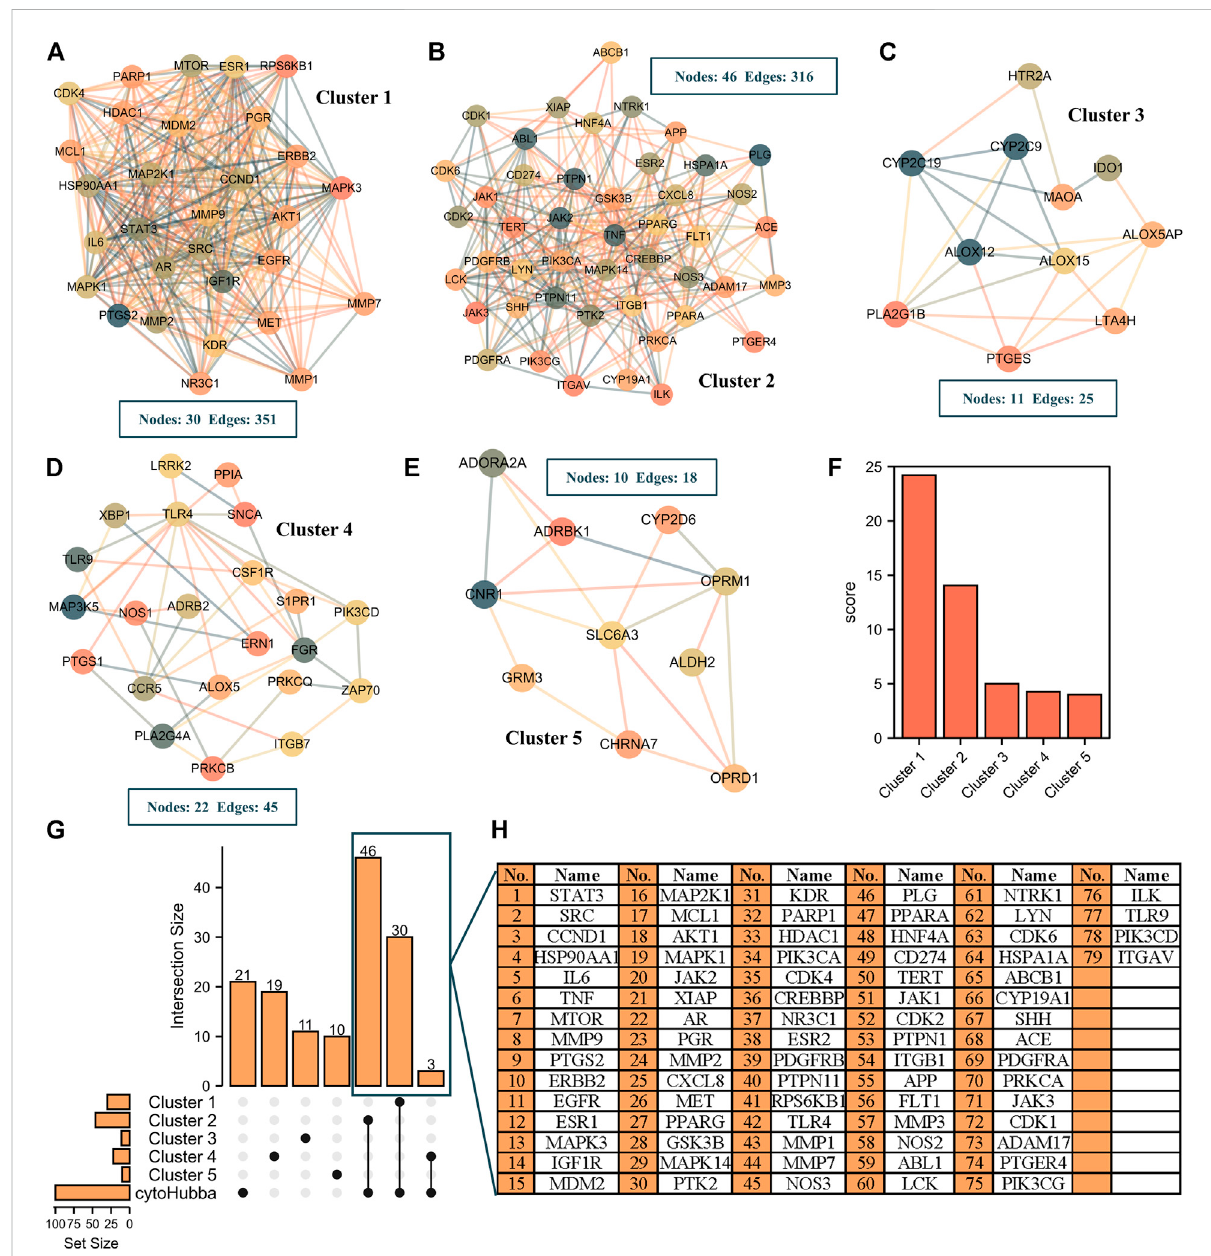
FIGURE 2 ScreeningofkeytargetsinthetreatmentofRAwithWPW. (A – E) TheclustermodulewithaScore ≥ 4inthePPInetworkwasobtainedbyMCODE plug-in Cytoscape. (F) The score for the fi vecluster modules. (G) The upset plotwas screened by MCODE and Cytohubba. (H) A list of 79 keytargets in the upset